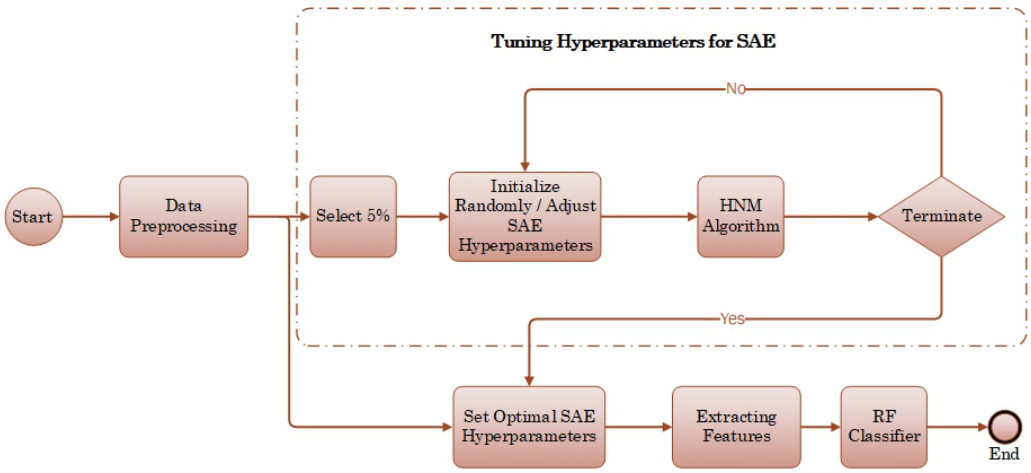
Figure 1. Architecture of the proposed IDS based on enhanced SAE and